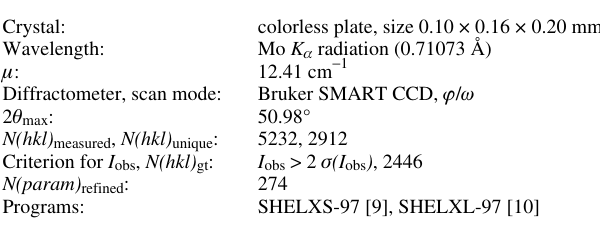
Table 1. Data collection and handling.